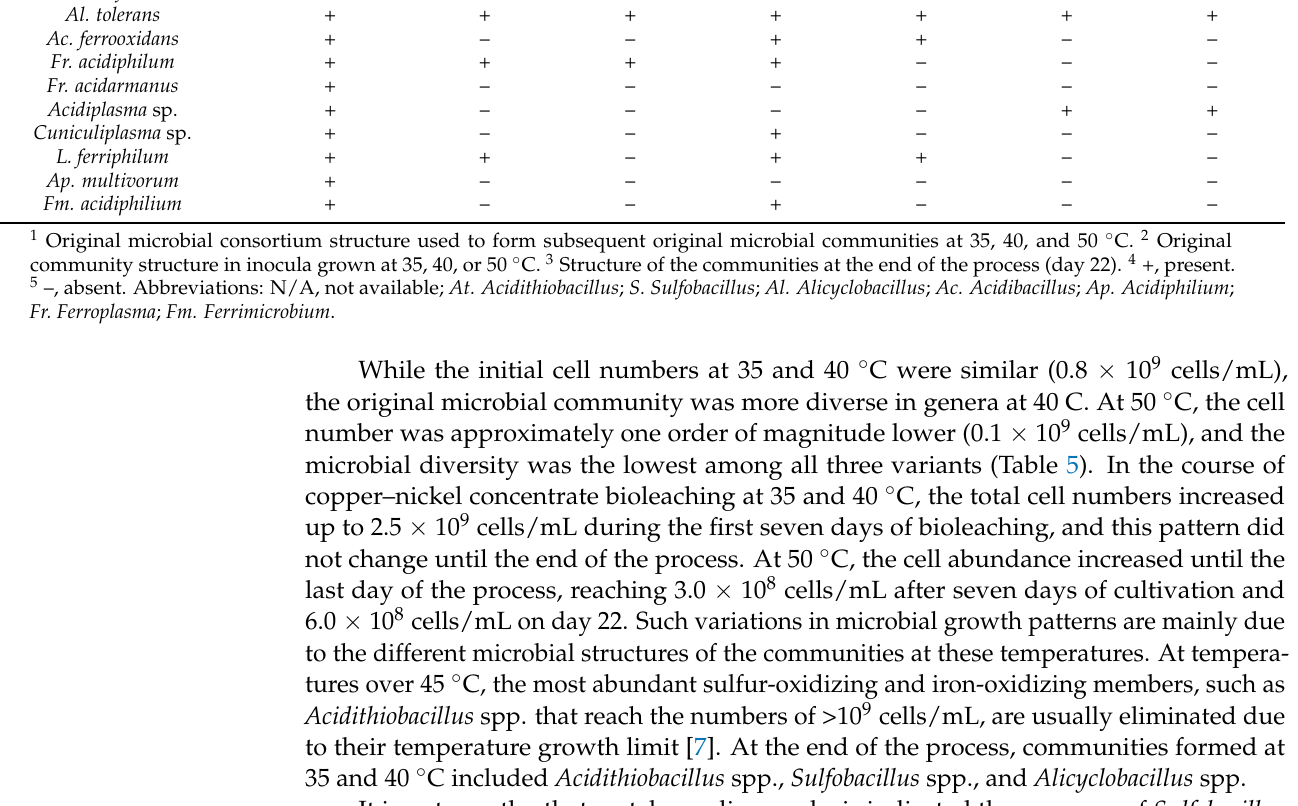
Table 5. Structure of the microbial communities at the beginning and the end of the bioleaching of the concentrate at different temperatures.